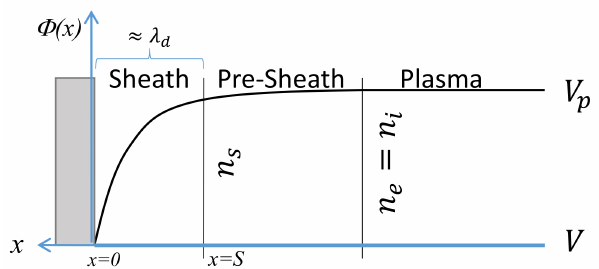
Figure A1. Voltage close to the plasma—object interface vs.